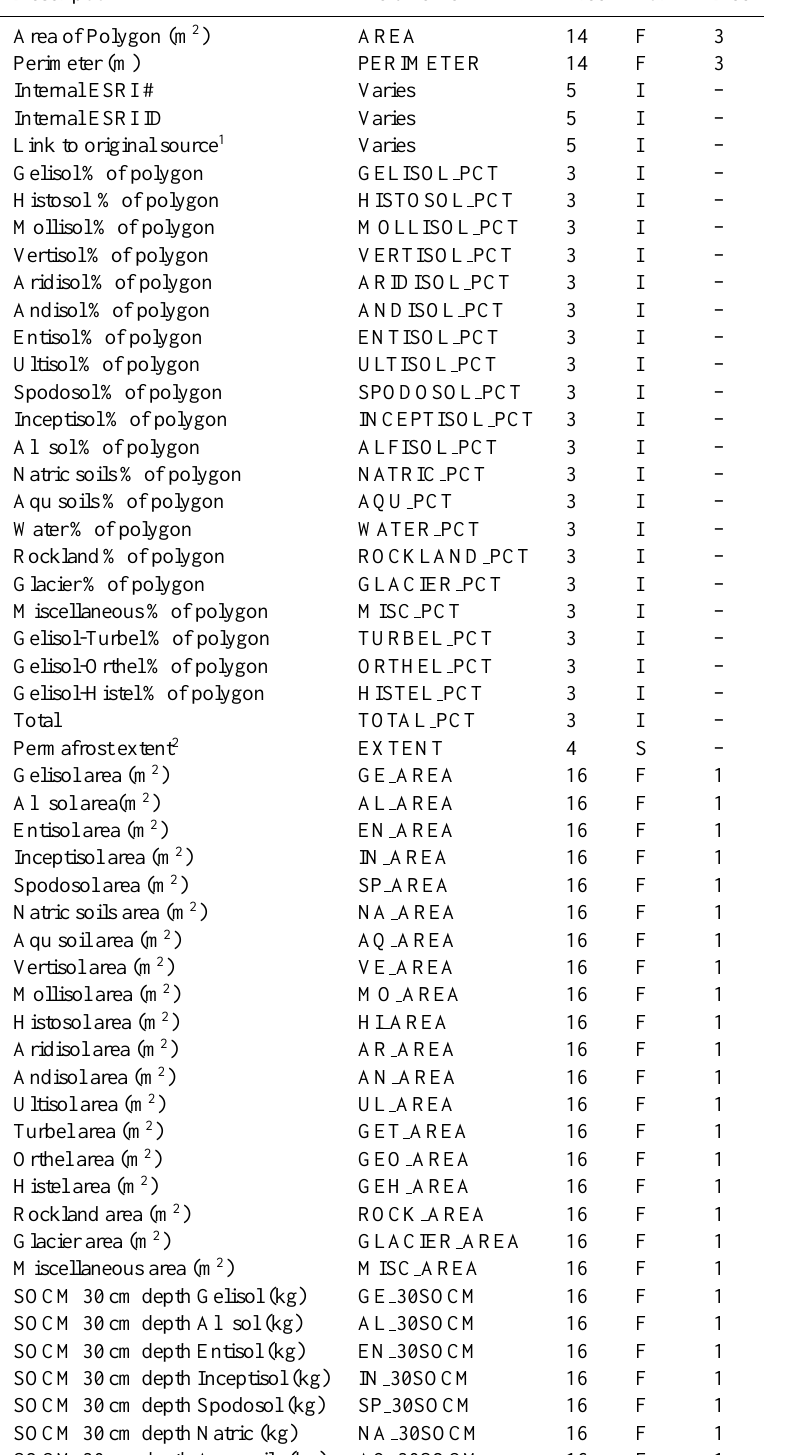
Table 2. Description of the data contained in the polygon attribute tables of NCSCD. The table gives a description of the data, the column field name, the precision of numeric fields (Prec), the data format the variable is stored in (Form: F = float numeric field, I = integer numeric field, S = string) and the number of decimal values of float numeric fields